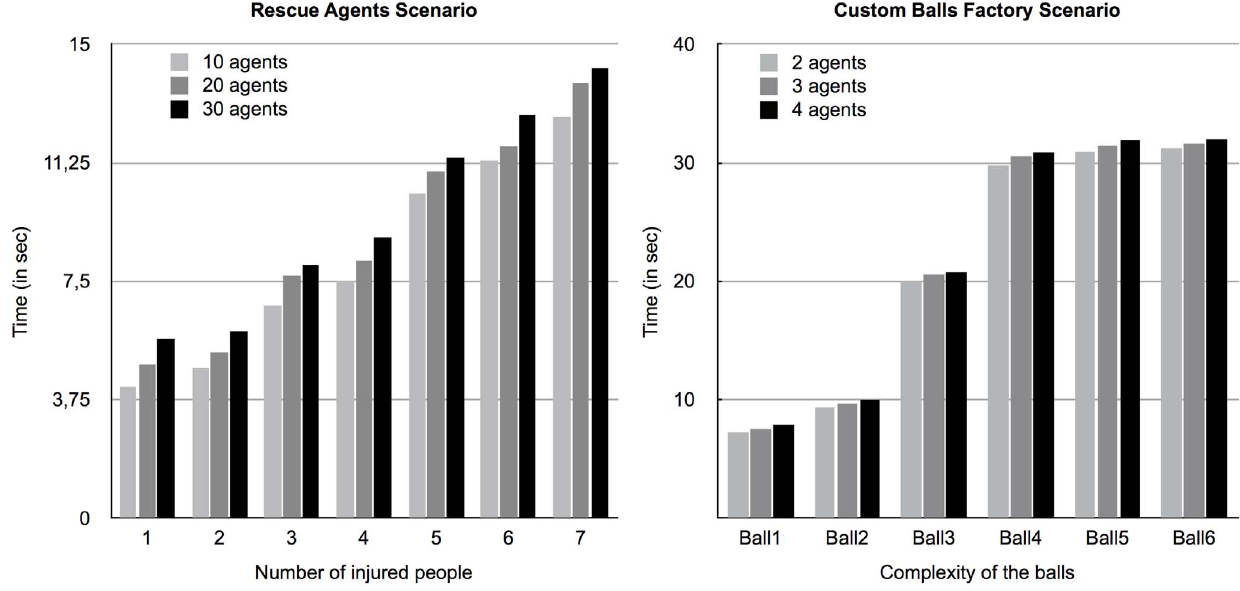
Figure 5. Evolution of performance of the algorithm in both testing scenarios (2). Evolution of performance of the Operators-graph-based Distributed Graphplan in both testing scenarios (with the Rescue Agents scenario on the left panel and the Custom Balls Factory scenario on the right panel) as skills distribution increase using a specific heuristic. The given number of agents is per skill.